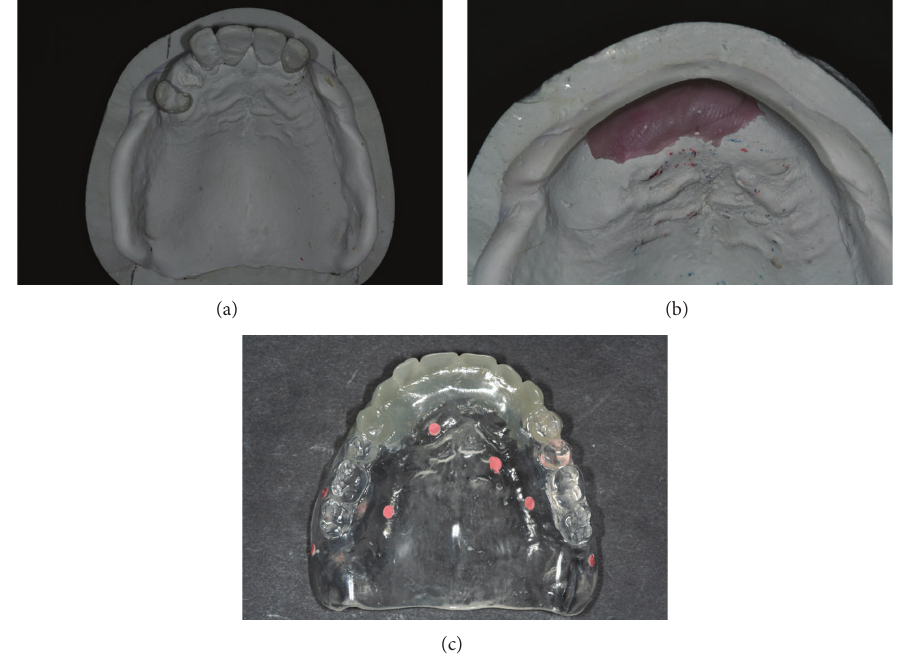
Figure2:((a)and(b))Teetharecutofffromthemastermodelaccordingtotheperiodontalprobingdata.Inthiscase,anadditionalosteotomy has been planned according to the prosthetic needs. (c) The radiographic template is repositioned on the master model and an additional set-up is done. This additional set-up is then polymerized. Observe that the location of the radiographic markers at this stage must remain the